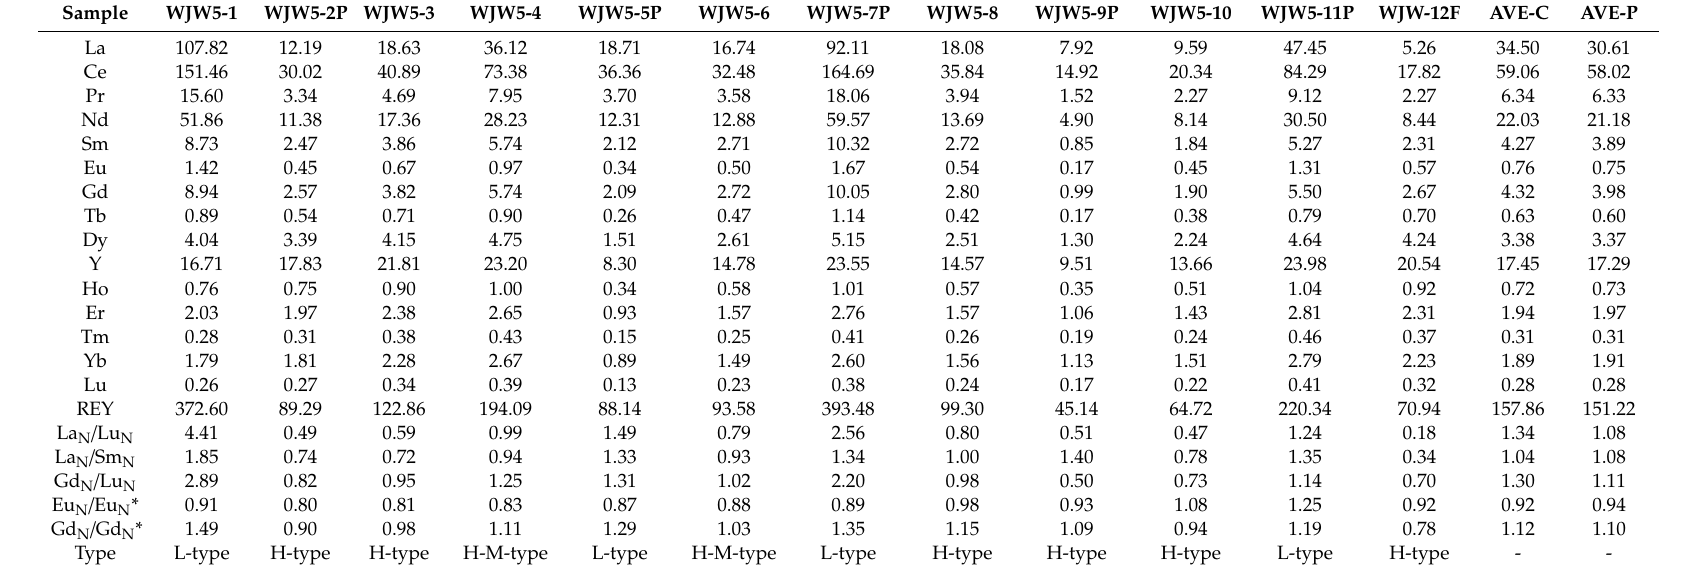
Table 4. Concentrations of Rare Earth Elements and Y (REY) in the coals and partings from the No. 5 coal seam.